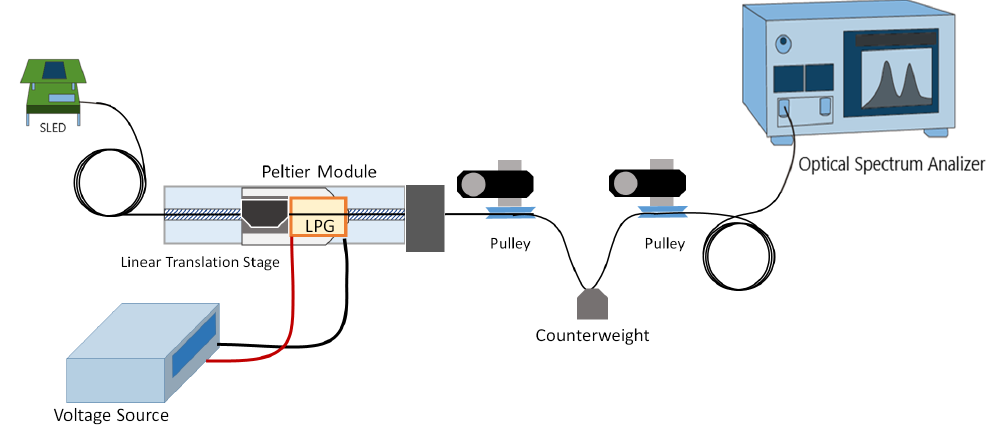
Figure 8. Experimental setup used for temperature characterization of engraved